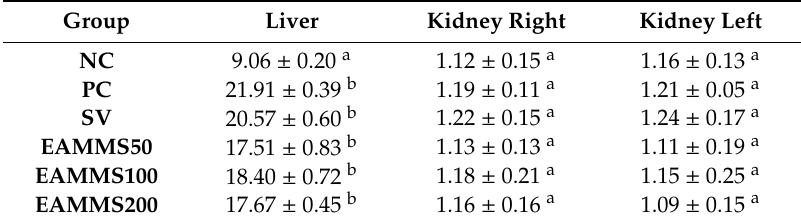
Table 1. Organ weight of rats at week 8.